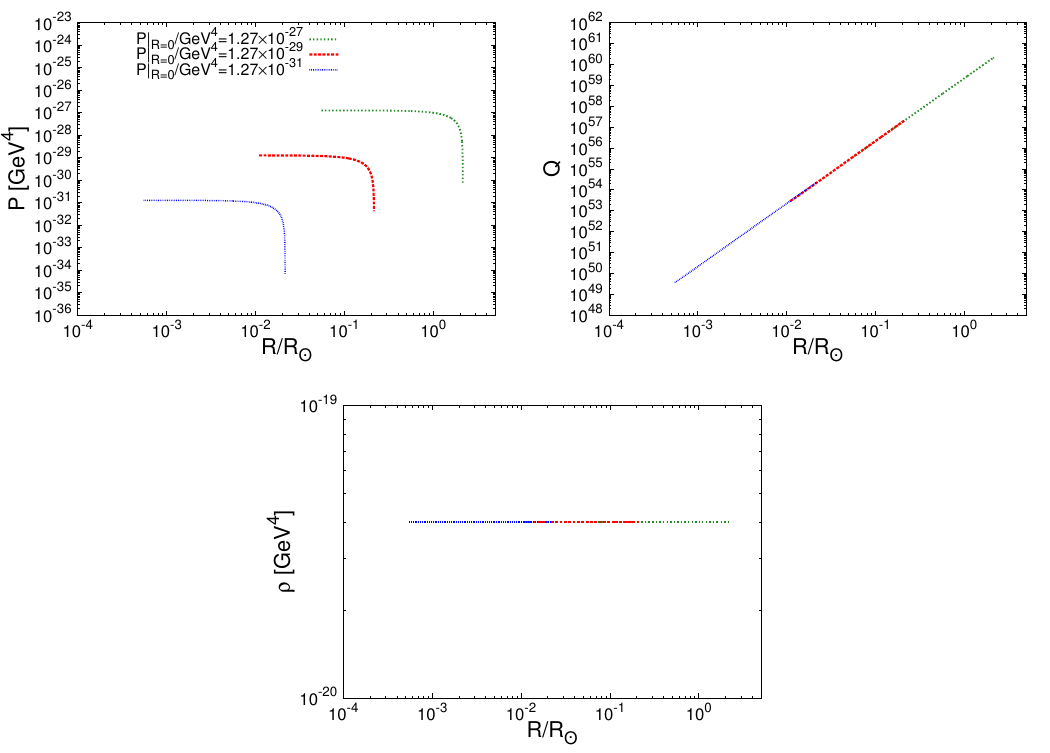
Figure 2 . The pressure P (upper-left), Q -charge within radius R (upper-right), and en- ergy density profile (bottom) of a FB with B 1 / 4 = 10 keV for three boundary conditions, P | R =0 = 1 . 27 × 10 − 27 GeV 4 , P | R =0 = 1 . 27 × 10 − 29 GeV 4 , and P | R =0 = 1 . 27 × 10 − 31 GeV 4 . Correspondingly, ( M FB /M (cid:12) , R FB /R (cid:12) ) = (6 . 5079 × 10 − 2 , 2 . 149) , (6 . 4911 × 10 − 5 , 0 . 2149) , and (6 . 5079 × 10 − 8 , 2 . 149 × 10 − 2 )